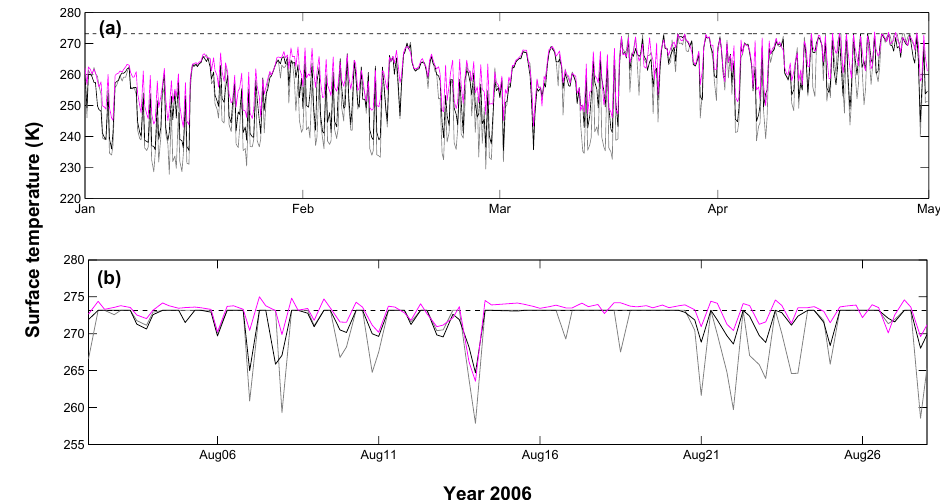
Figure 8. (a) Winter hourly surface temperature (snow surface) from January to May 2006, measured using outgoing LW radiation at AWS m (pink) and simulated without (grey) and with (black) wind speed correction. (b) Summer hourly surface temperature measured using outgoing LW at AWS g06 (pink) and simulated without (grey) and with (black) wind speed correction from 9 July to 28 August 2006. Dashed line corresponds to the melting